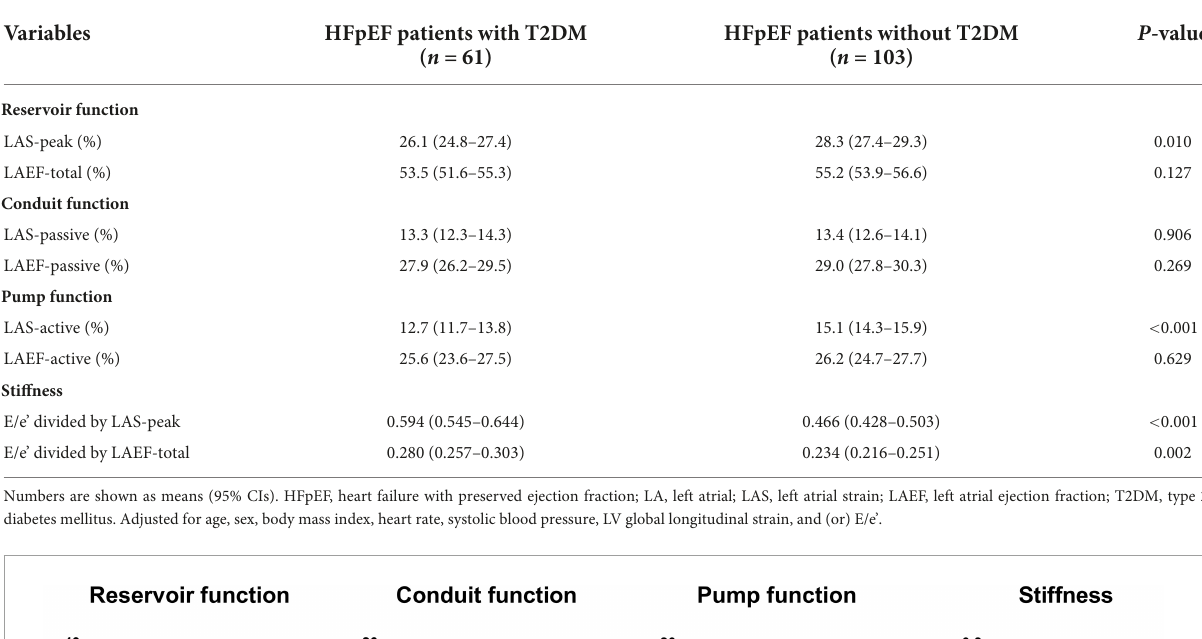
TABLE 3 Adjusted comparisons of LA function and stiffness between HFpEF patients with and without T2DM.